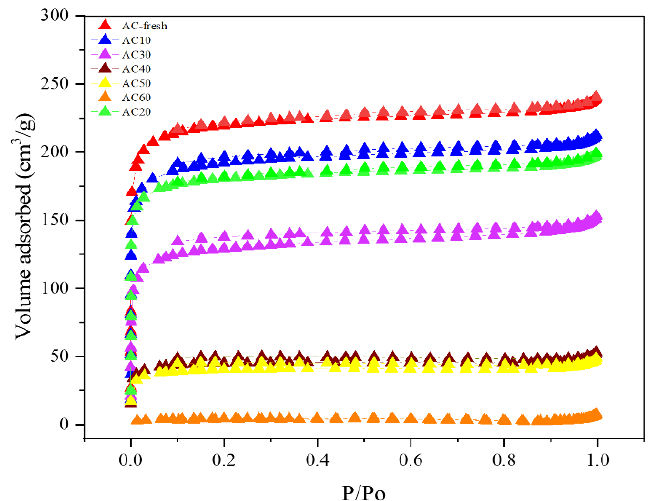
Figure 7. N 2 adsorption–desorption isotherm of fresh AC and functionalized with different amounts of IL at 77 K.